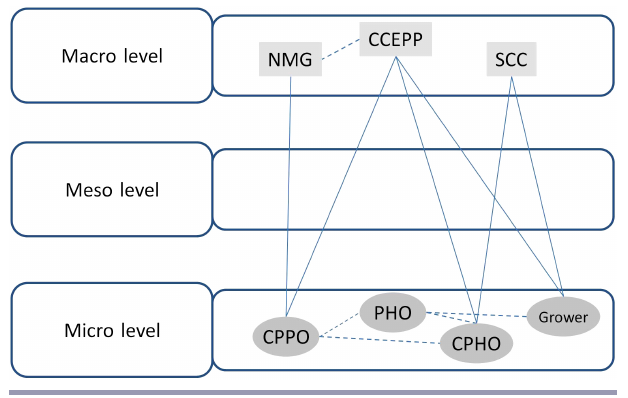
Fig. 2 . Multilevel biosecurity network, with organizational actors (micro level) and committees and working groups (macro level) connected via ties representing processes and formal lines of communication. Organizational actors are connected to committees or working groups via ties based on their participation (meso level, solid ties). For definitions of node acronyms, see Fig. 1.